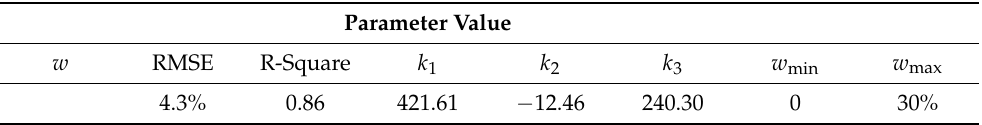
Table 1. Estimated parameter values of the soil moisture fitting curve in Equation (6) based on the in situ